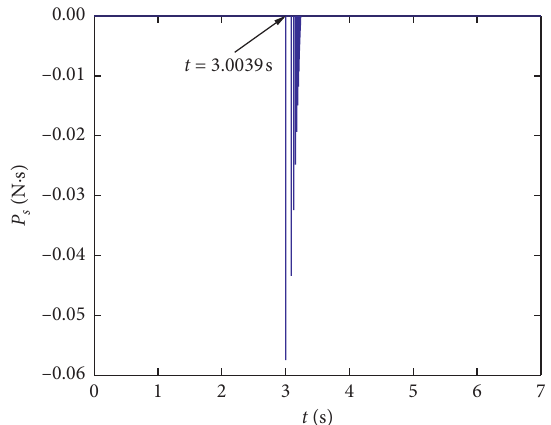
Figure 12: The impulse moment in the whole simulation process.